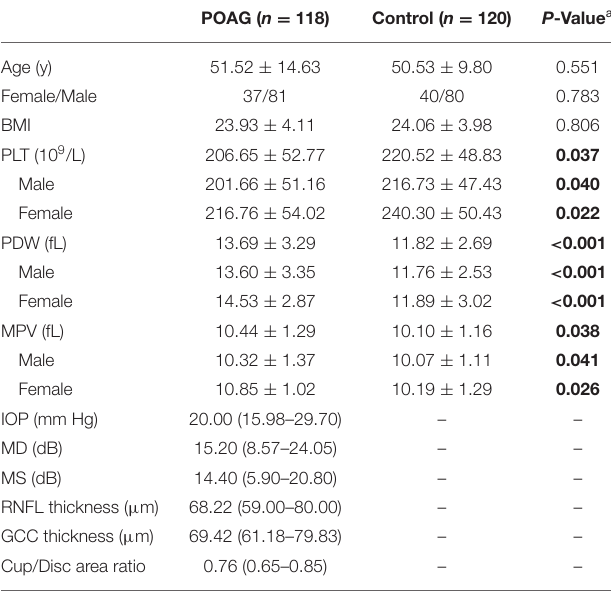
TABLE 1 | Characteristics of the study